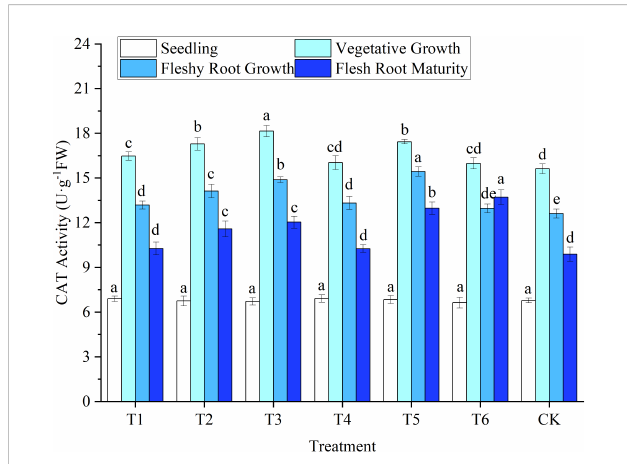
FIGURE 7 Response of catalase activity in woad plants in different water de fi cits. Different lowercase letters in the same column mean the signi fi cant differences among treatments according to LSD ( P < 0.05). Data were presented as mean ± SE (n =